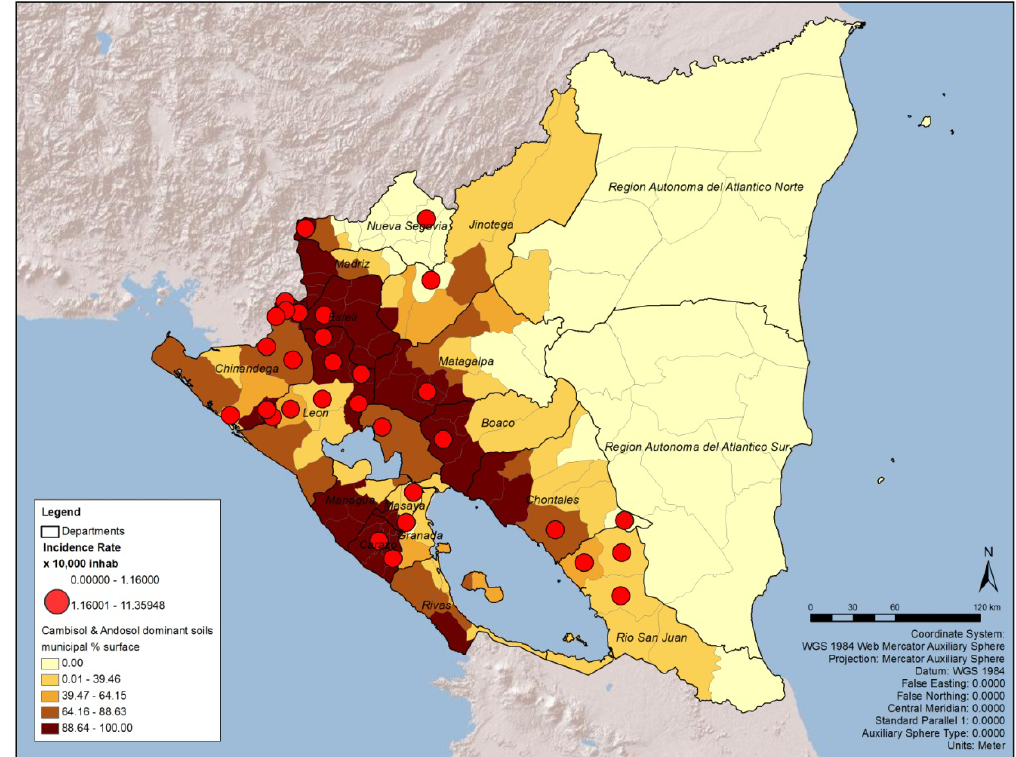
Figure 4. Critical areas for leptospirosis define by incidence rate and percentage of soil with Cambisol and Andosol, by municipality, Nicaragua,